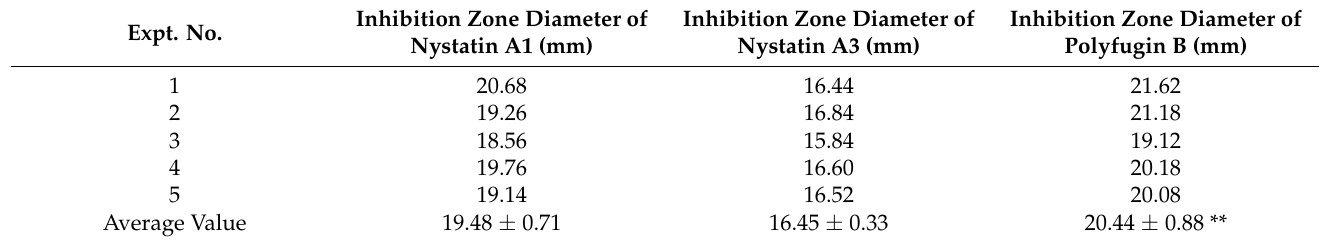
Table 6. Results of nystatin A1, A3, and polyfungin B inhibiting Saccharomyces cerevisiae ATCC 2061. Expt.